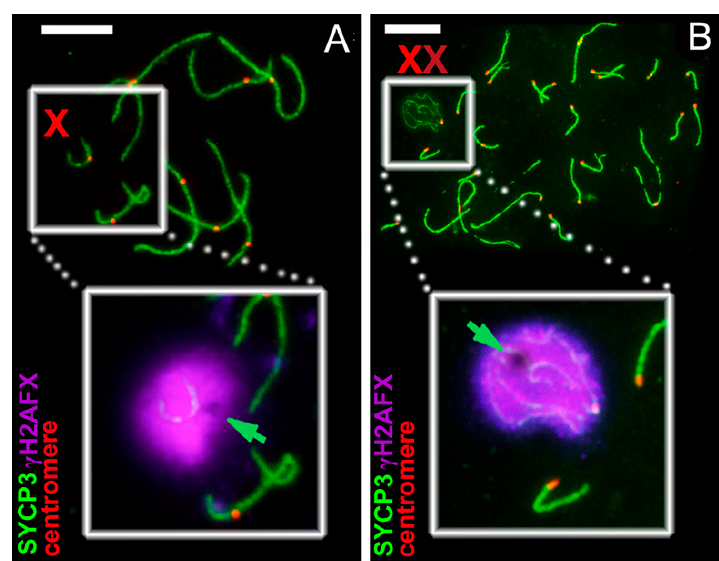
Figure 3. Immunostaining of pachytene spermatocytes from E. lutescens ( A ) and E. tancrei ( B ). Axial SC elements were identified using anti ‐ SYCP3 antibodies (green), anti ‐ CREST for kinetochores (red) and anti ‐γ H2AFX as marker of chromatin inactivation (magenta). ( A ) the X ‐ univalent is replaced to the periphery of the meiotic nucleus, formed sex body and shrouded by γ H2AFX. A γ H2AFX ‐ negative round body is noticeable in the X sex body (green arrow); ( B ) during the middle pachytene, XX bivalent was replaced to the periphery of the meiotic nucleus, formed sex body and surrounded by γ H2AFX. A chromatin body ( ChB ) was often γ H2AFX ‐ negative (green arrow). Bar = 5 μ m. Sibling species E. talpinus , E. tancrei and E. alaicus maintained a unique system of sex chromosomes, X Х ♂ /X Х ♀ (Figure 2I). Their X chromosomes were large acrocentrics with identical G ‐ band patterns. Starting from the zygotene stage, the X chromosomes synapsed between the short